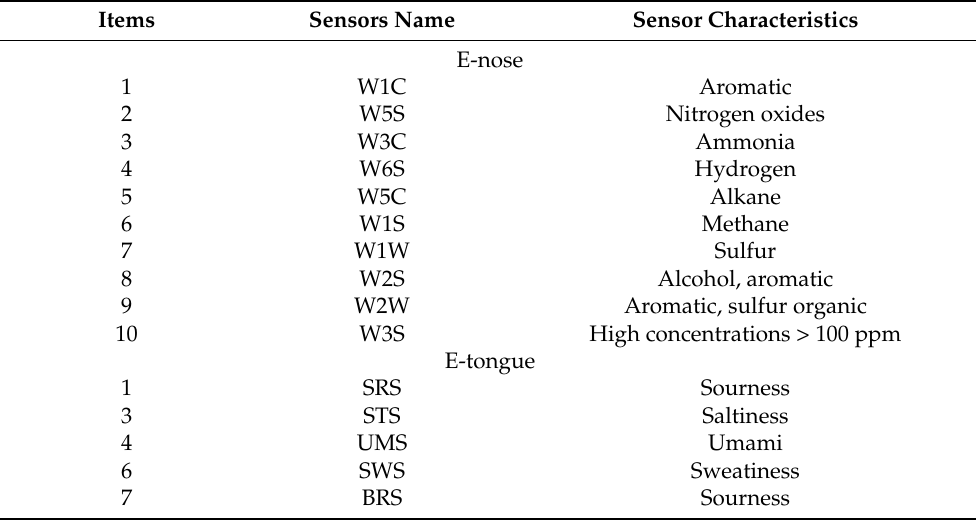
Table 2. Electronic nose sensors and electronic tongue sensors and their performance